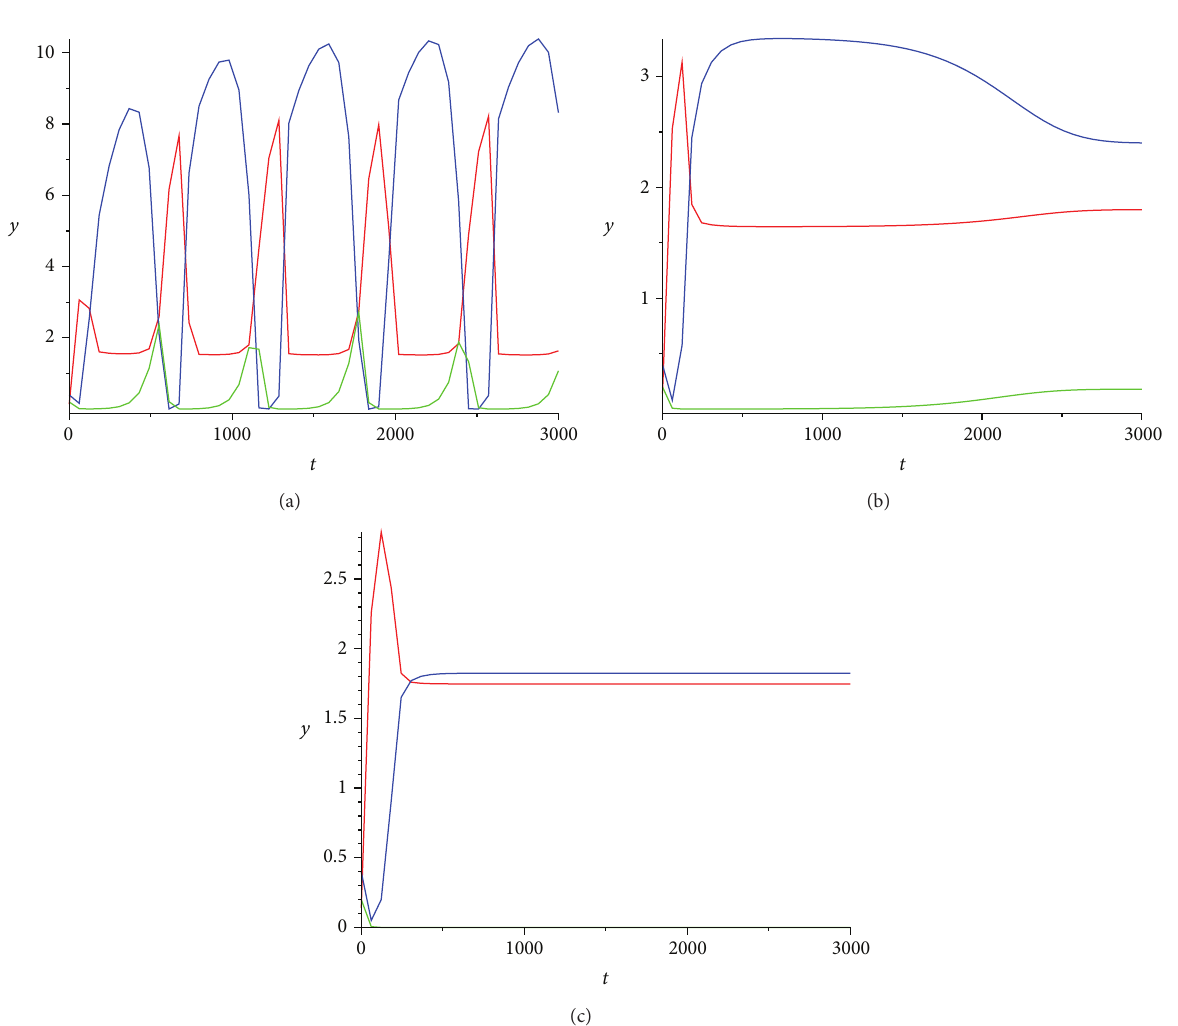
measure to Taihu Lake, and this indicates that our model is reasonable for Taihu Lake at the same